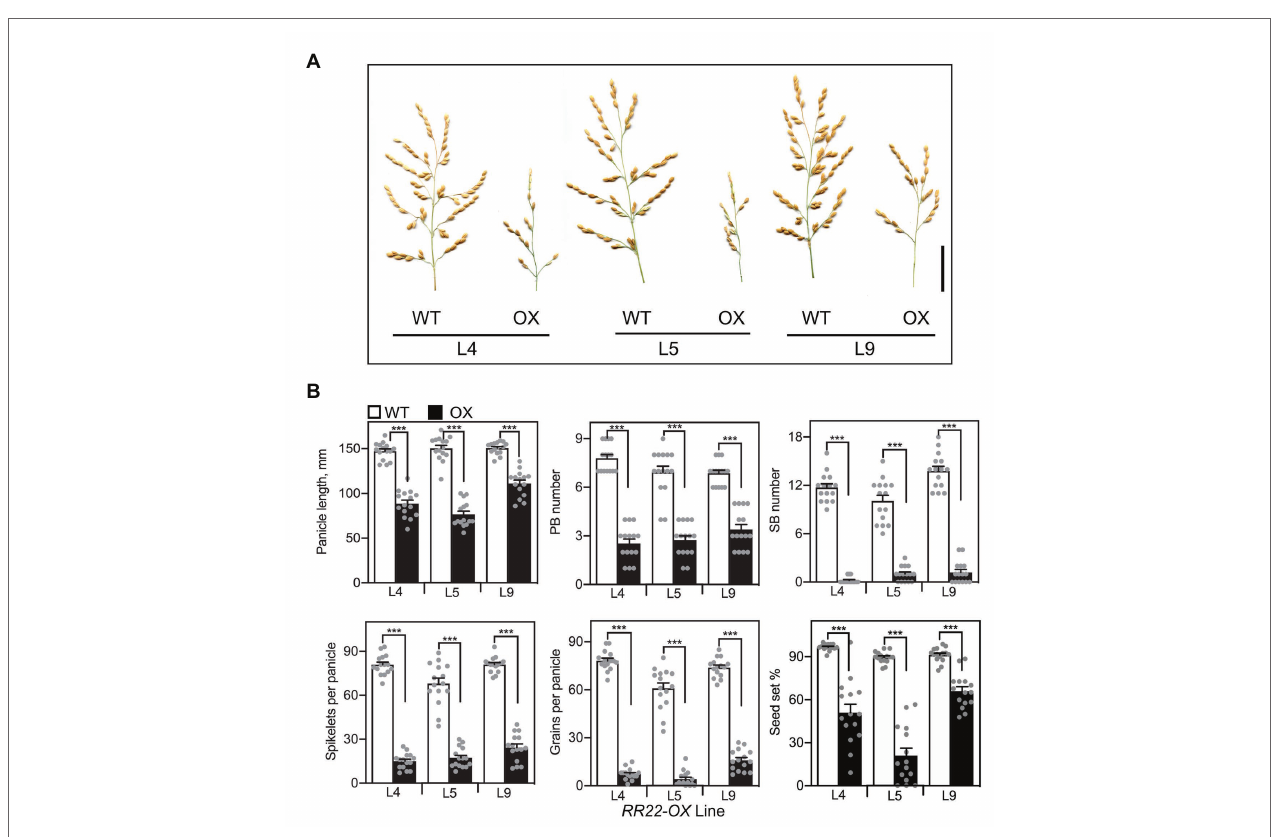
FIGURE 5 | Panicle phenotypes of RR22-OX lines. (A) Panicles of RR22-OX lines and their WT siblings. Scale bar = 5 cm. (B) Yield parameters of the RR22-OX lines, including panicle length, primary branch (PB) and secondary branch (SB) number, spikelets and grains per panicle, and percent seed set ( n = 15). Error bars show SE. The T -test was used for statistical comparison of each RR22-OX line to its WT sibling (*** p <